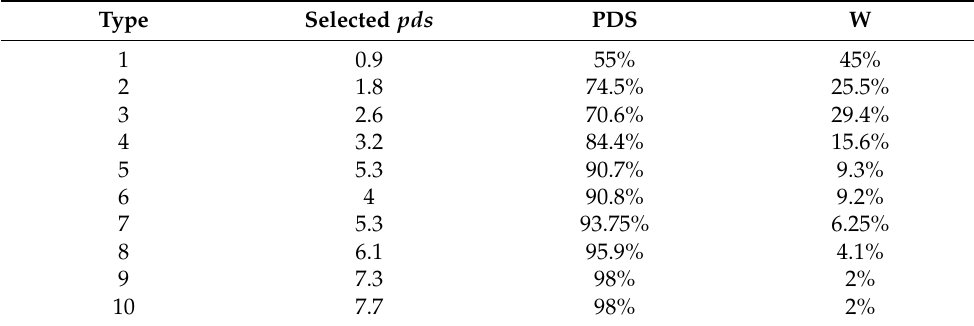
Table 3. First computational test. Results of the selected pds and served